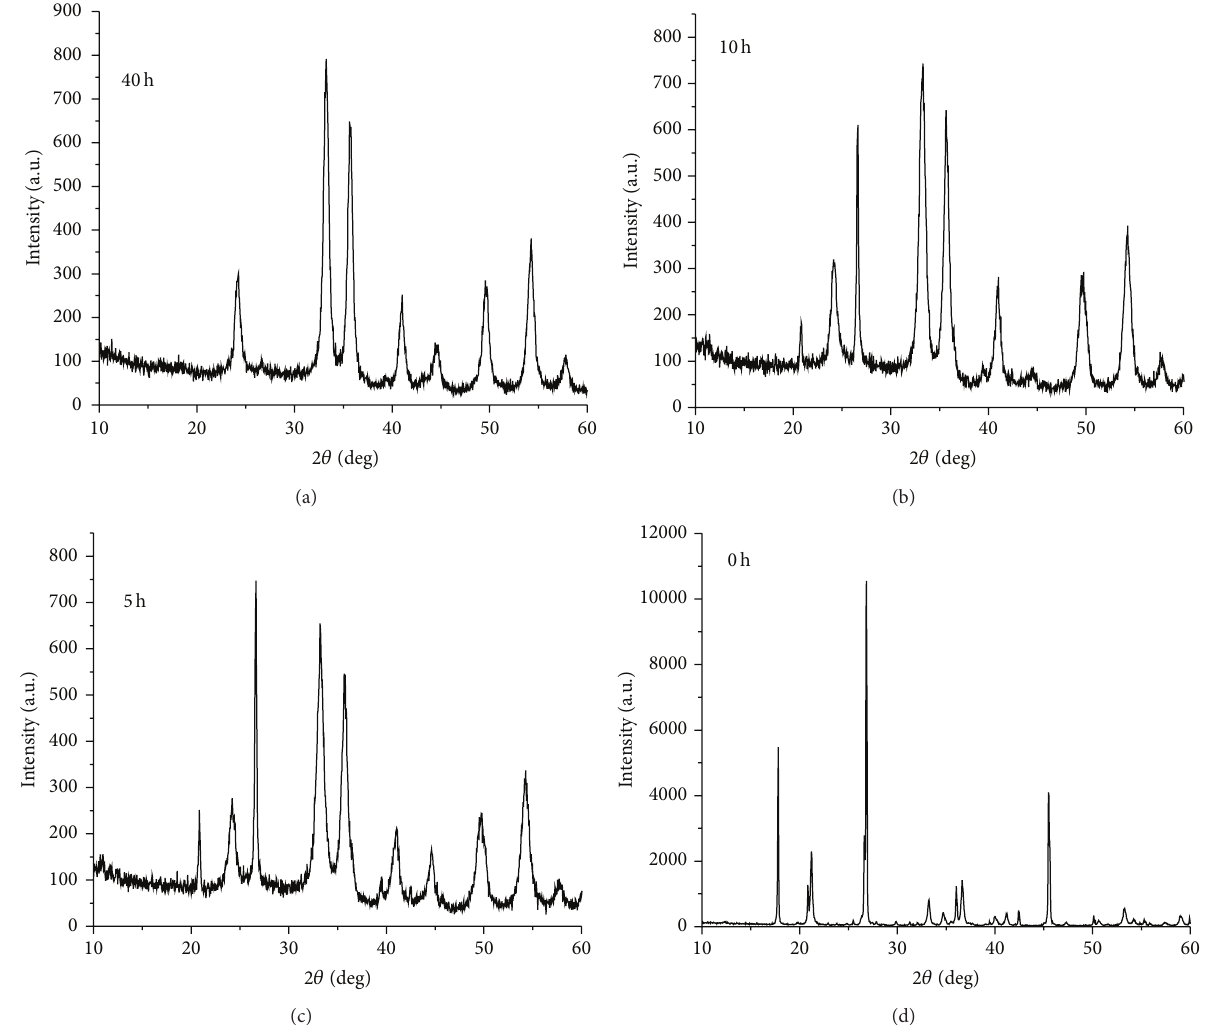
Figure 1: XRD patterns of goethite powder as received and milled for several